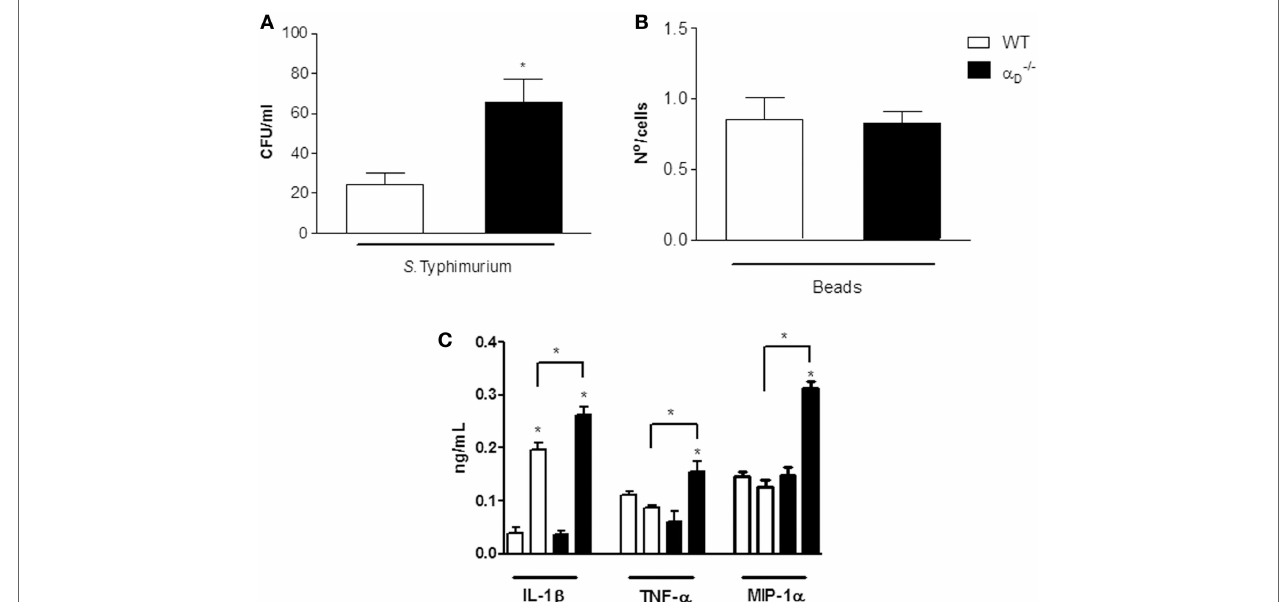
FIGURE 5 | Integrin α D β 2 regulates Salmonella Typhimurium killing and release of inflammatory cytokines by peritoneal macrophages challenged in vitro . (A) Peritoneal macrophages (10 6 cells/mL) were collected from wild-type (WT) or α –/– D mice and challenged in vitro with S. Typhimurium (10 5 CFU/mL) or incubated in medium alone for 1h at 37 ◦ C. The medium was removed, and the cells were incubated for an additional hour with fresh medium without antibiotics. After 1h of incubation at 37 ◦ C, the macrophages were lysed with saponin (0.1%), and bacterial CFU were determined in each sample. (B) WT and α –/– D peritoneal macrophages were incubated with latex particles (10 7 /well). The media were removed, and fresh media added as in panel (A) , and the number of intracellular beads counted by light microscopy. Each bar indicates the mean (cid:6) SEM of beads in 100 consecutively counted cells. (C) Supernatants were collected from peritoneal macrophages infected with S . Typhimurium or from uninfected peritoneal macrophages cultured as described in panel (A) after 1h of incubation and assayed for IL-1 β , TNF- α , and MIP-1 α (C) . Three to five wells were analyzed in each experiment. The data in this figure are representative of three experiments with similar results. Significant differences ( p < 0.05) between infected and control cells are indicated by asterisks and between cells from α –/– D and WT animals by bars with